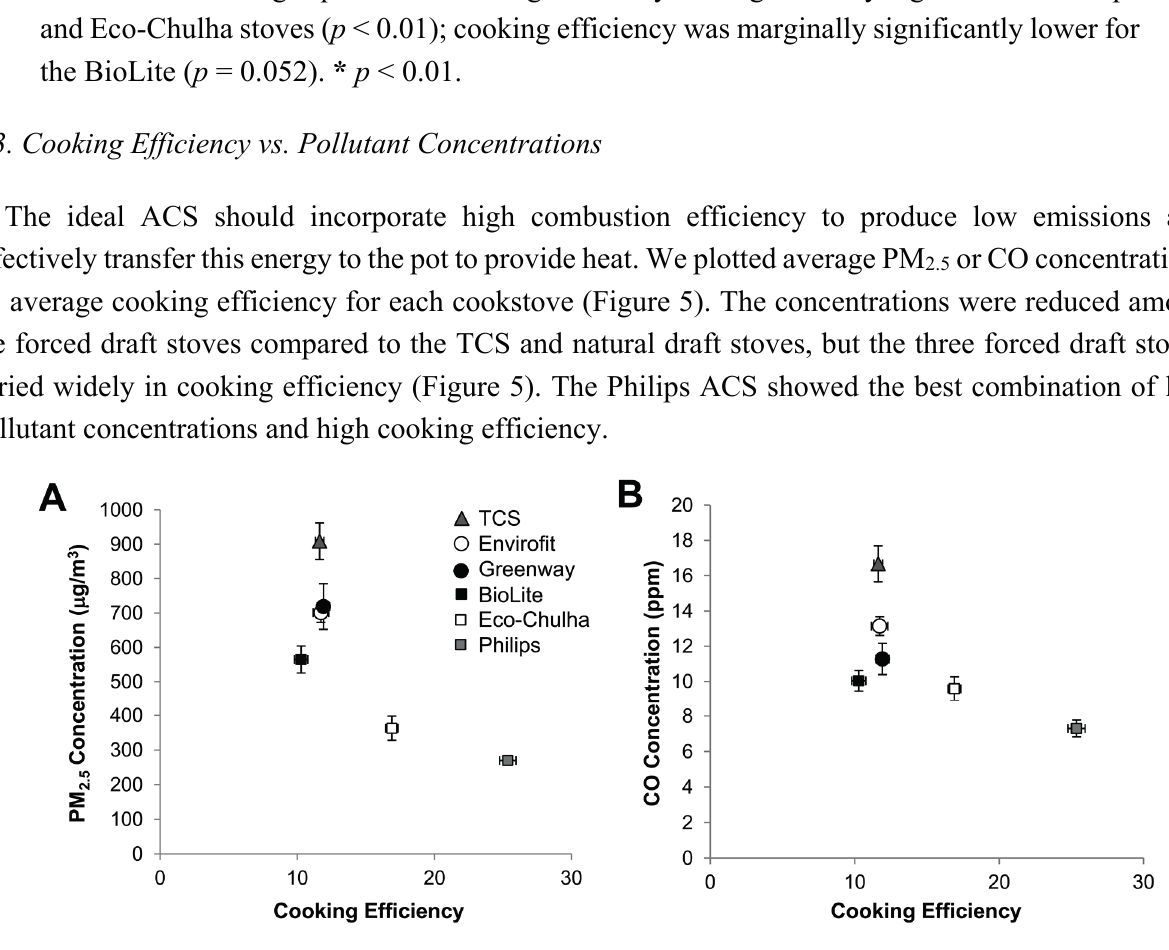
Figure 5. Cooking efficiencies were compared to PM 2.5 concentrations ( A ) and CO concentrations ( B ) Data is presented as mean ±